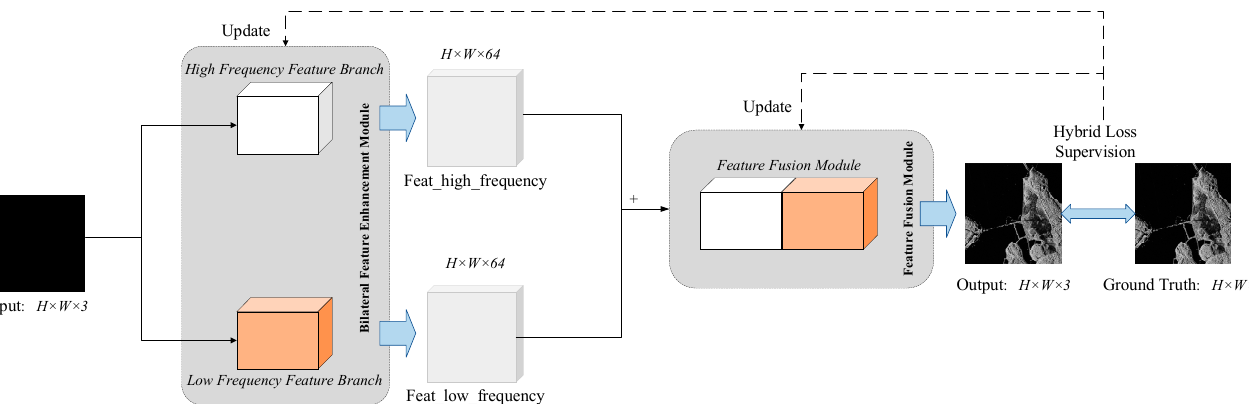
Figure 1. Overview of the proposed decomposition-fusion framework.